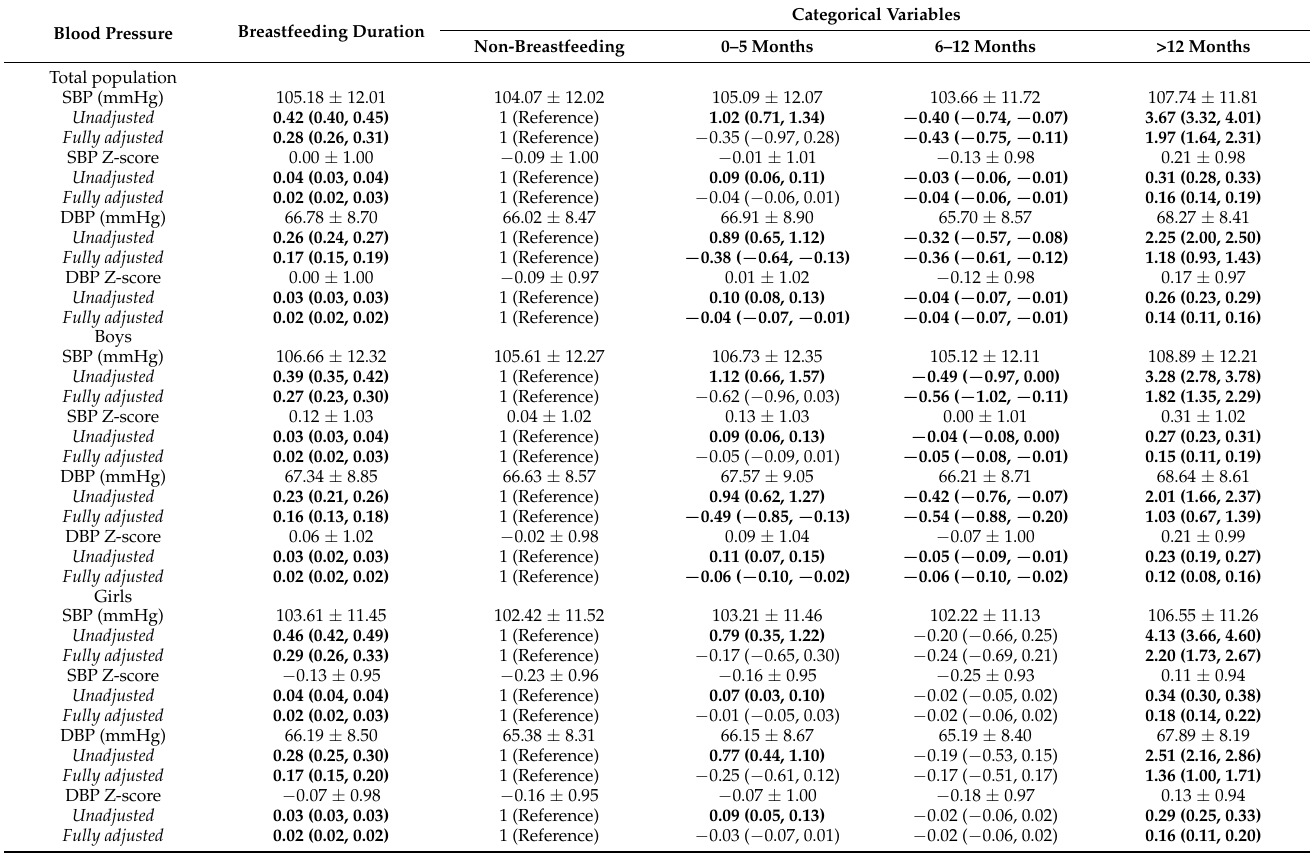
Table 2. Multiple linear regression analysis of breastfeeding duration and BP and BP Z scores, β (95% CI).